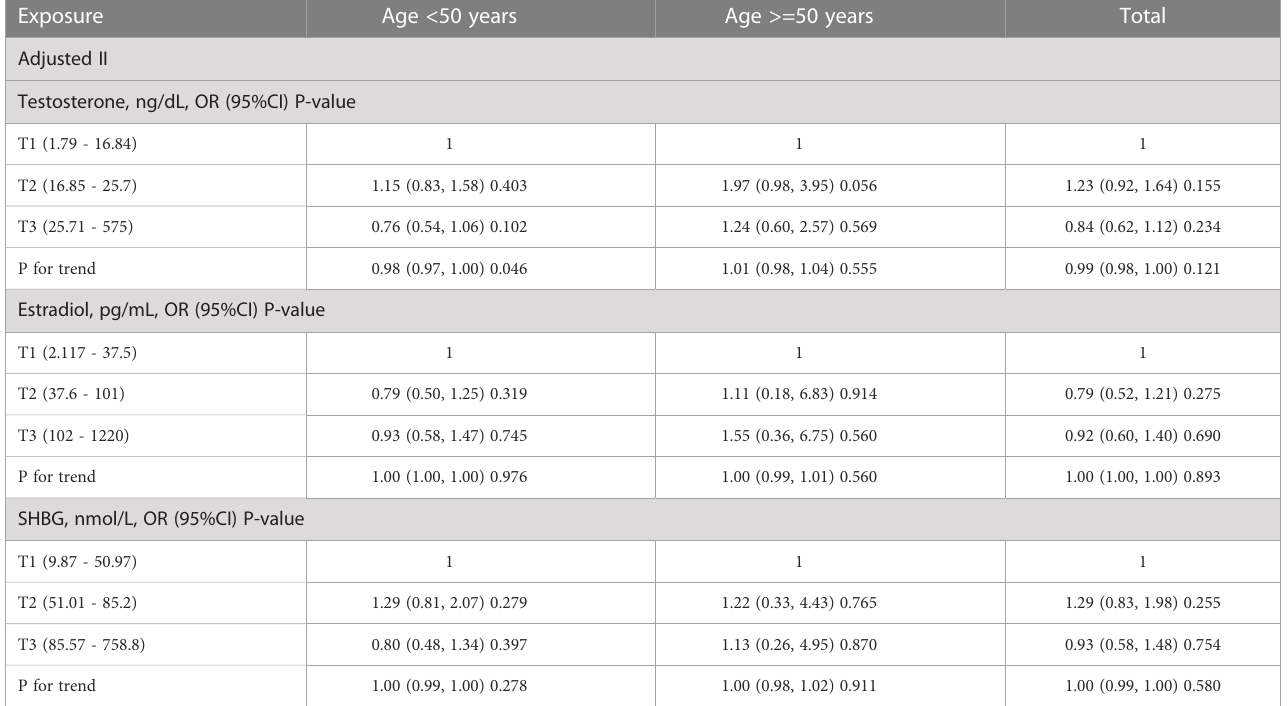
TABLE 5 The subgroup analysis of age for the association of sex hormone levels and periodontitis in